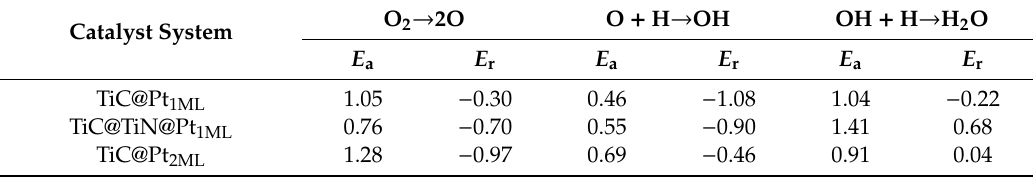
Figure 4. The reaction pathway of the O 2 dissociation mechanism on TiC@Pt 2ML . Table 4. The reaction barriers E a and reaction energy E r of the O 2 dissociation